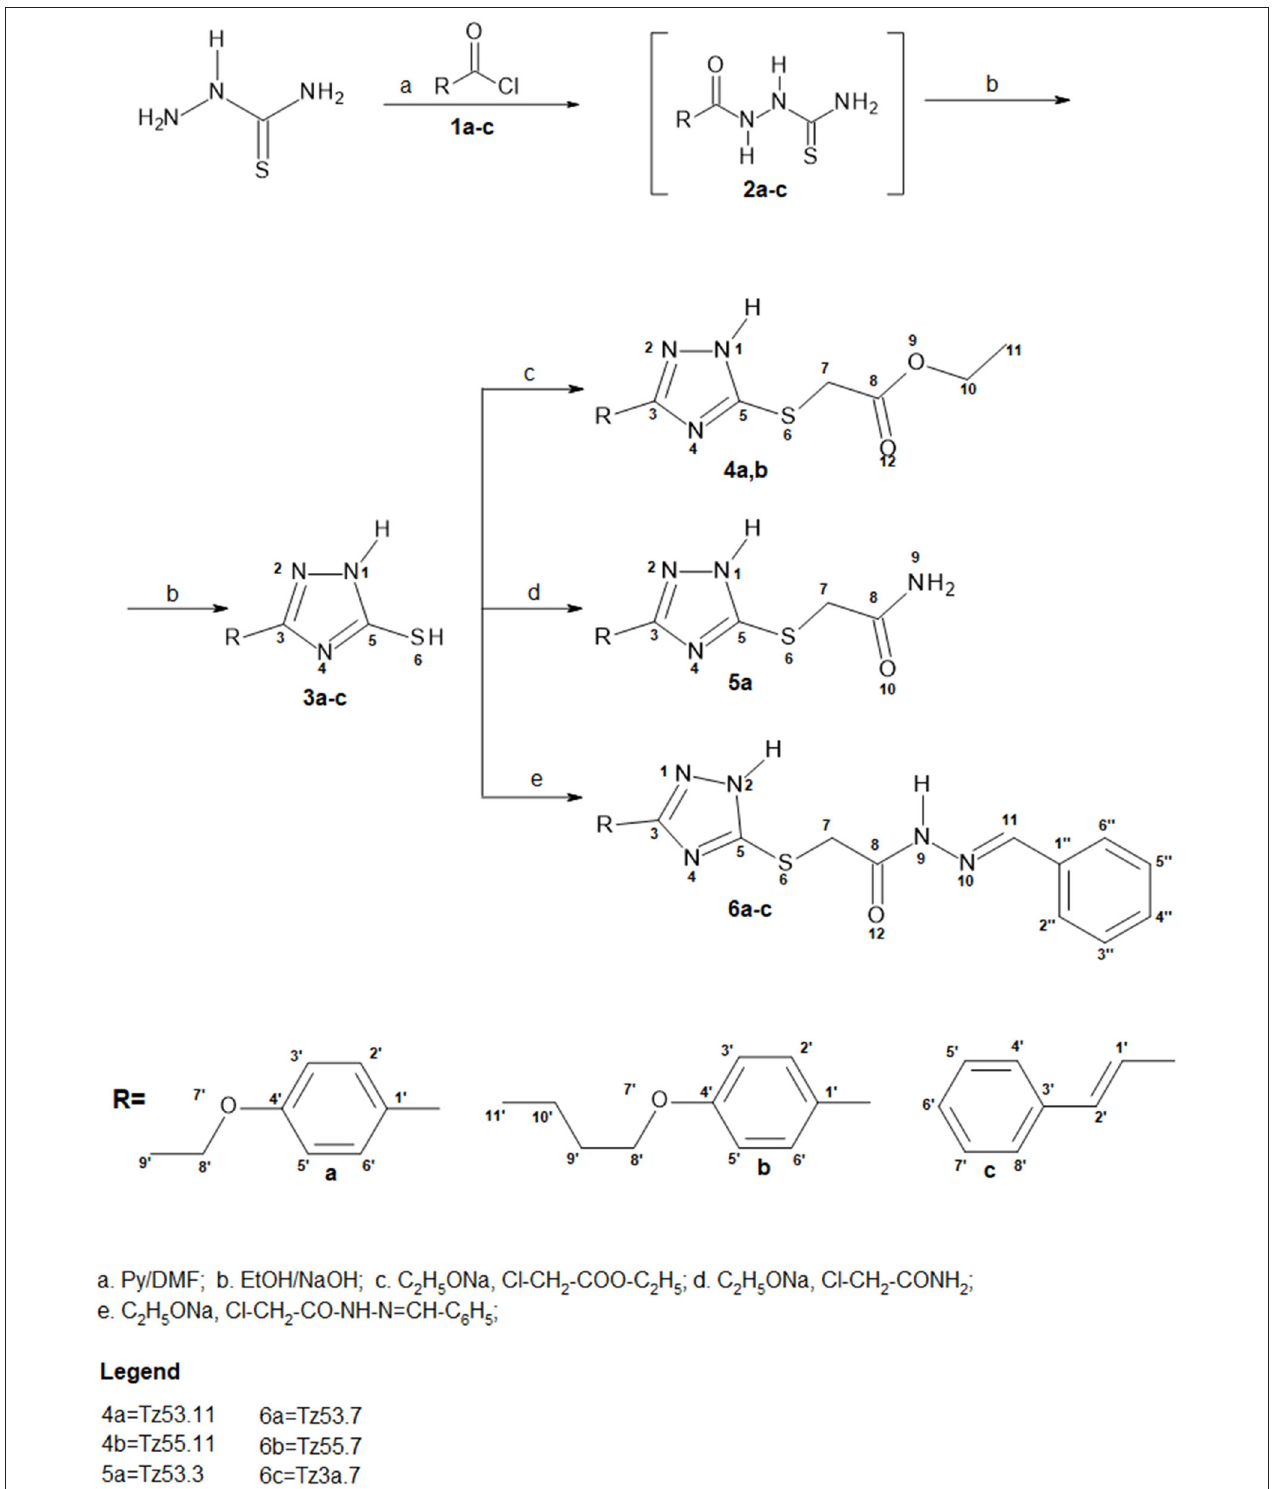
FIGURE 3 | Synthesis pathway of S-functionalized 1H-3-R-5-mercapto-1,2,4-triazoles.